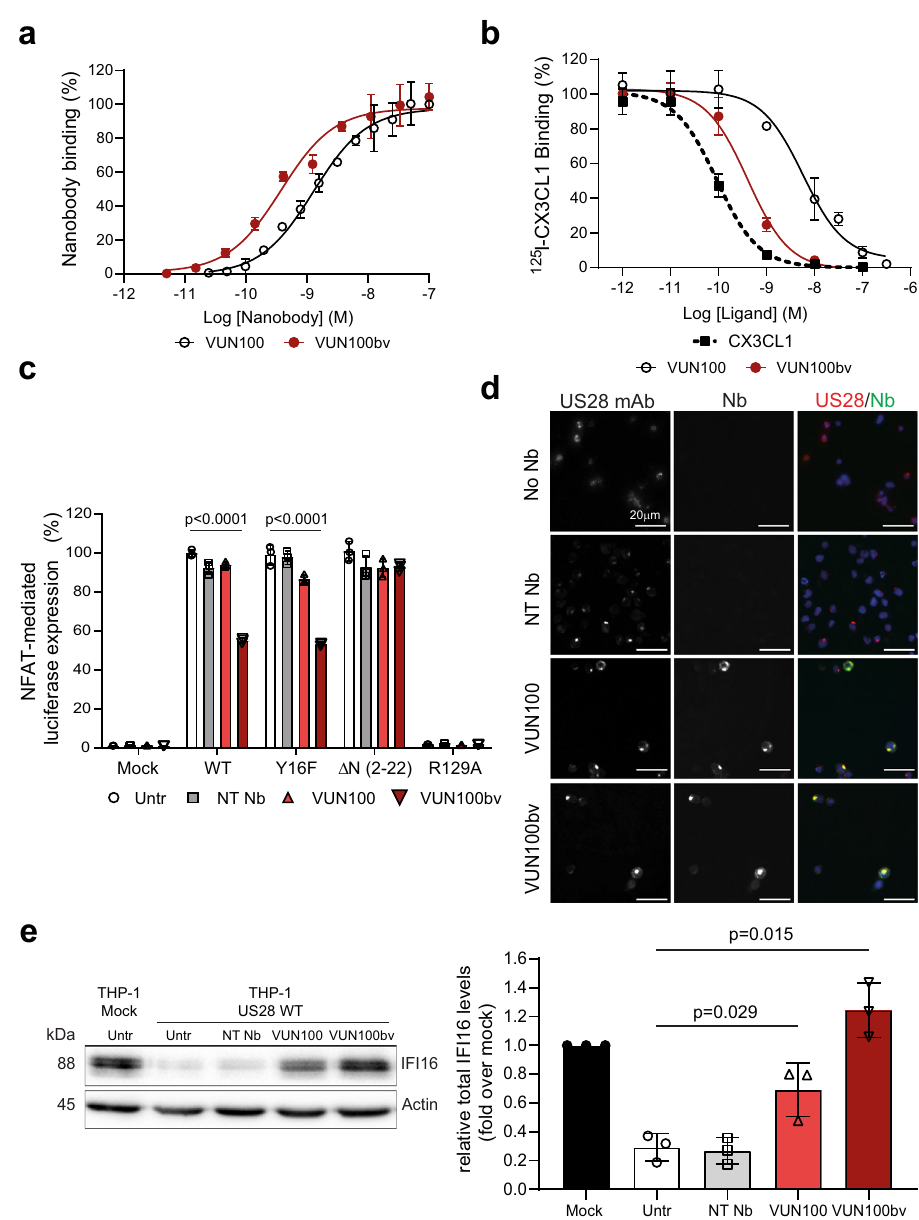
Fig. 1 VUN100bv binds and inhibits US28 signaling. a ELISA binding of monovalent VUN100 and bivalent VUN100bv to membrane extracts of US28- expressing HEK293T cells. Representative fi gure of three independent experiments. b Displacement of 125 I-CX3CL1 from US28-expressing membranes by unlabeled ligand or the nanobodies VUN100 and VUN100bv. Representative fi gure of three independent experiments. c Effect of nanobodies on US28- mediated NFAT (nuclear factor of activated T cells) activation. HEK293T cells expressing either NFAT-luciferase reporter only (Mock) or NFAT-luciferase reporter together with US28 wildtype receptor (WT), US28 Y16F mutant (Y16F), US28 Δ N (2 – 22) mutant ( Δ N (2 – 22)) or US28 R129A mutant (R129A). Cells were untreated (untr) or treated with a non-targeting nanobody (NT Nb), VUN100, or VUN100bv for 24 h prior to luminescence measurement. Data were normalized to the untreated WT samples. Representative fi gure of three independent experiments. d Immuno fl uorescence microscopy of nanobody binding to US28-expressing THP-1 cells. US28 was detected using a polyclonal rabbit-anti-US28 antibody (US28 mAb). Cells were incubated without nanobody (No Nb), an NT Nb, VUN100, or VUN100bv. Bound nanobody was detected using the Myc-tag present on the nanobodies and an anti-Myc antibody (Nb). Representative fi gure of three independent experiments. e Western blot detection for total IFI16 levels of lysates of untreated THP-1 mock transduced cells (THP-1 Mock) or US28-expressing THP-1 cells (THP-1 US28 WT). THP-1 US28 WT cells were untreated (Untr) or treated with NT Nb, VUN100, or VUN100bv for 48 h. IFI16 protein levels were determined and normalized to actin protein levels. Relative IFI16 protein levels were normalized to untreated THP-1 mock cell lysates. n = 3 independent experiments from three independent biological replicates. All data are plotted as mean ± S.D. For all data, except for Fig. 1c, statistical analyses were performed using an unpaired two-tailed t test. For Fig. 1c, statistical signi fi cance was determined using the Holm – Sidak method (two-sided with alpha = 0.05). Source data are provided as a Source Data fi